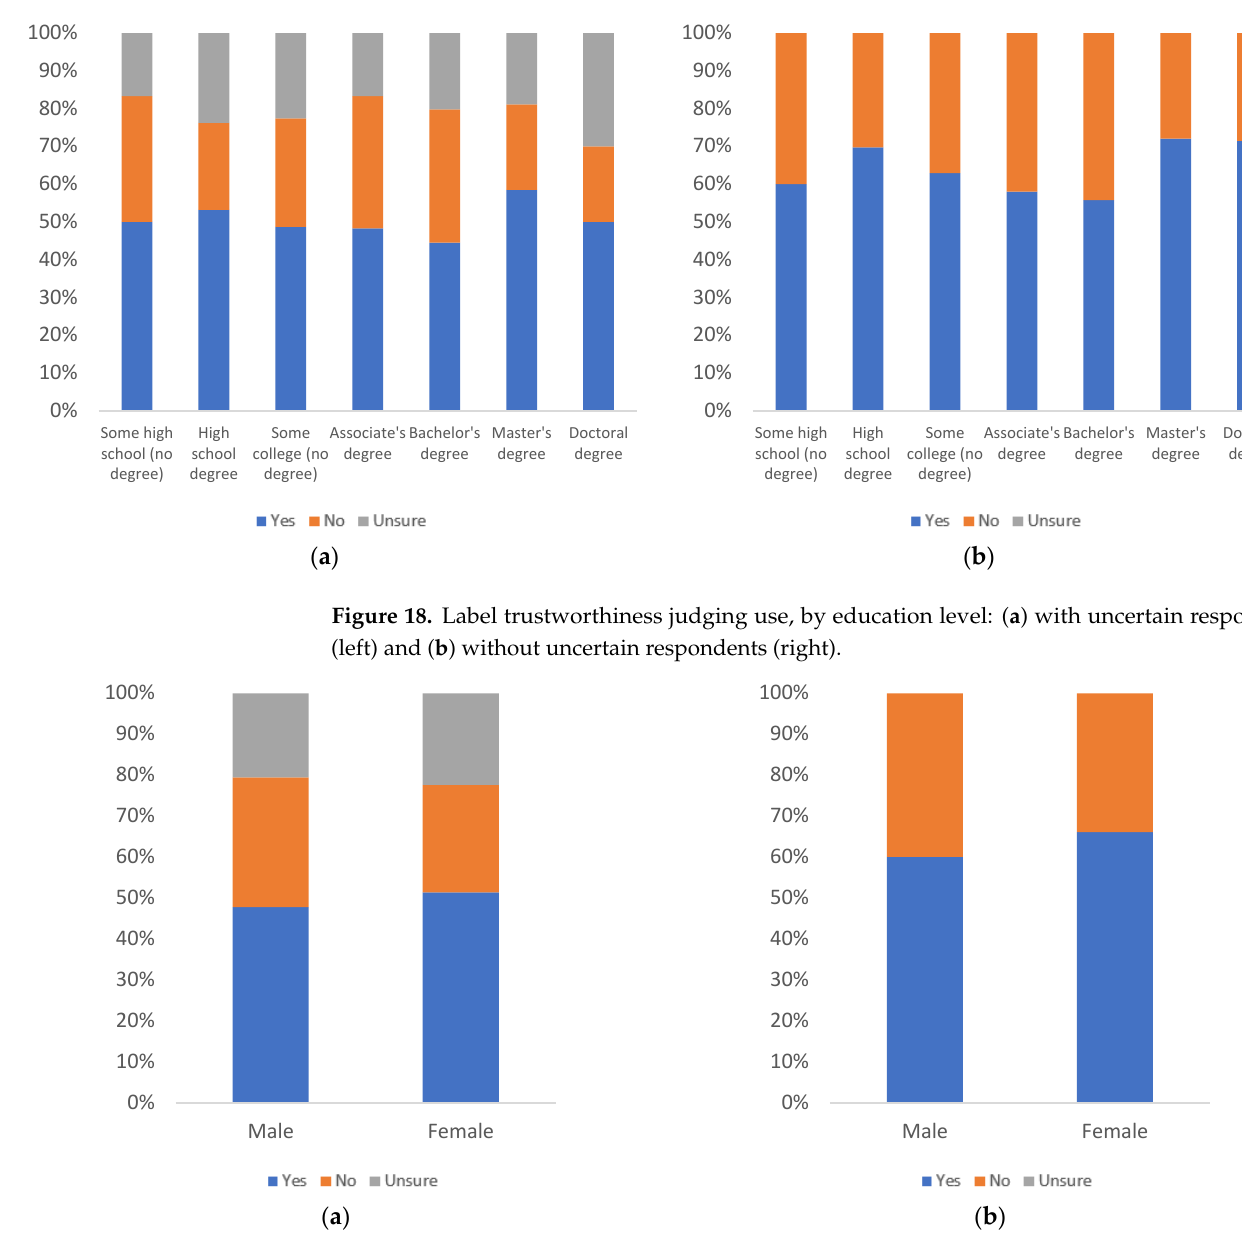
Figure 17. Label trustworthiness judging use, by age group: ( a ) with uncertain respondents (left) and ( b ) without uncertain respondents (right).